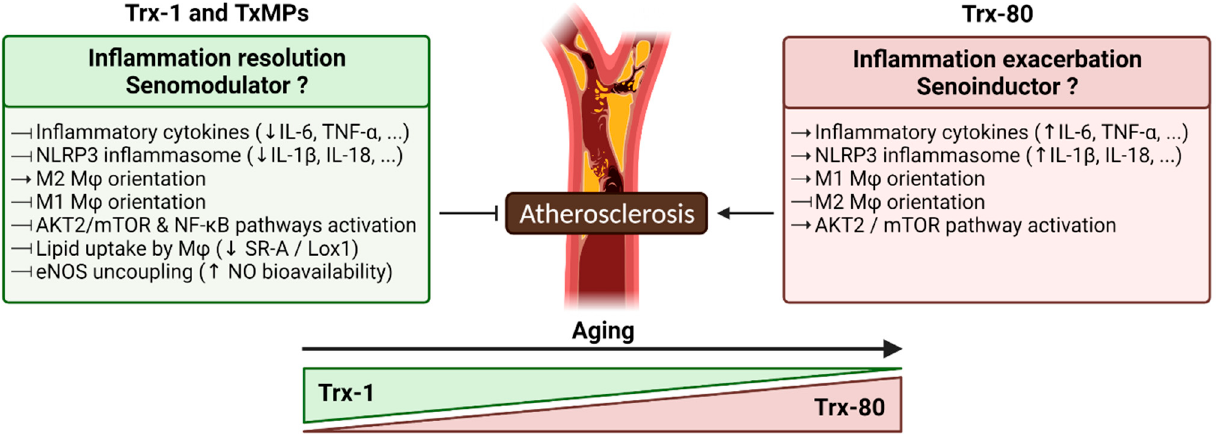
Figure 4. Summary of the principal features of thioredoxin system in atherosclerosis. Truncated thioredoxin (Trx-80) acts as an inflammatory and atherosclerosis inducer while Trx-1 and TxMPs counteract key inflammatory pathways and exert an antiatherogenic effect.